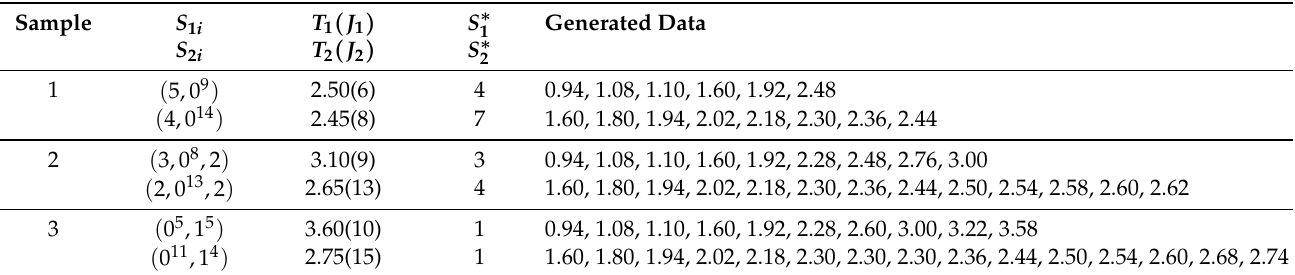
Figure 9. Estimated RF and PP plots for ( a ) Normal use condition and ( b ) Accelerated stress condition from micro-droplet data. Table 4. Different artificial APT-IC samples from micro-droplet